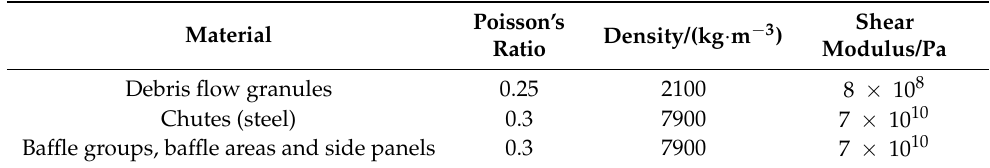
Table 7. The material intrinsic